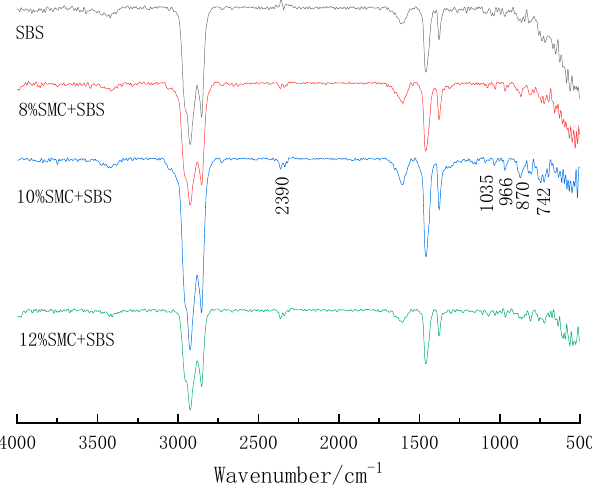
Figure 8. Infrared spectra of SBS and SMCSBS with different content.